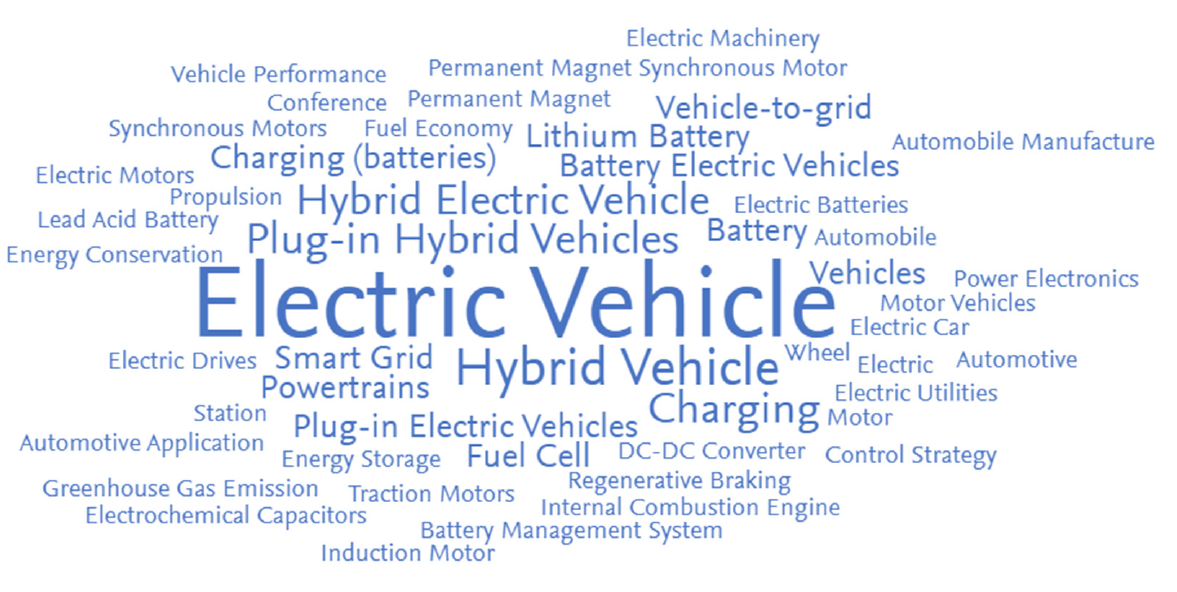
Figure 4. Key phrases based on XEV publications in 2012 .